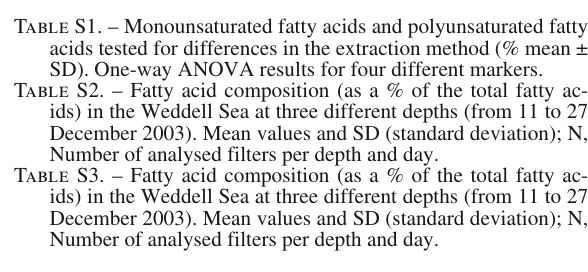
Table S1. – Monounsaturated fatty acids and polyunsaturated fatty acids tested for differences in the extraction method (% mean ± SD). One-way ANOVA results for four different markers. Table S2. – Fatty acid composition (as a % of the total fatty ac-